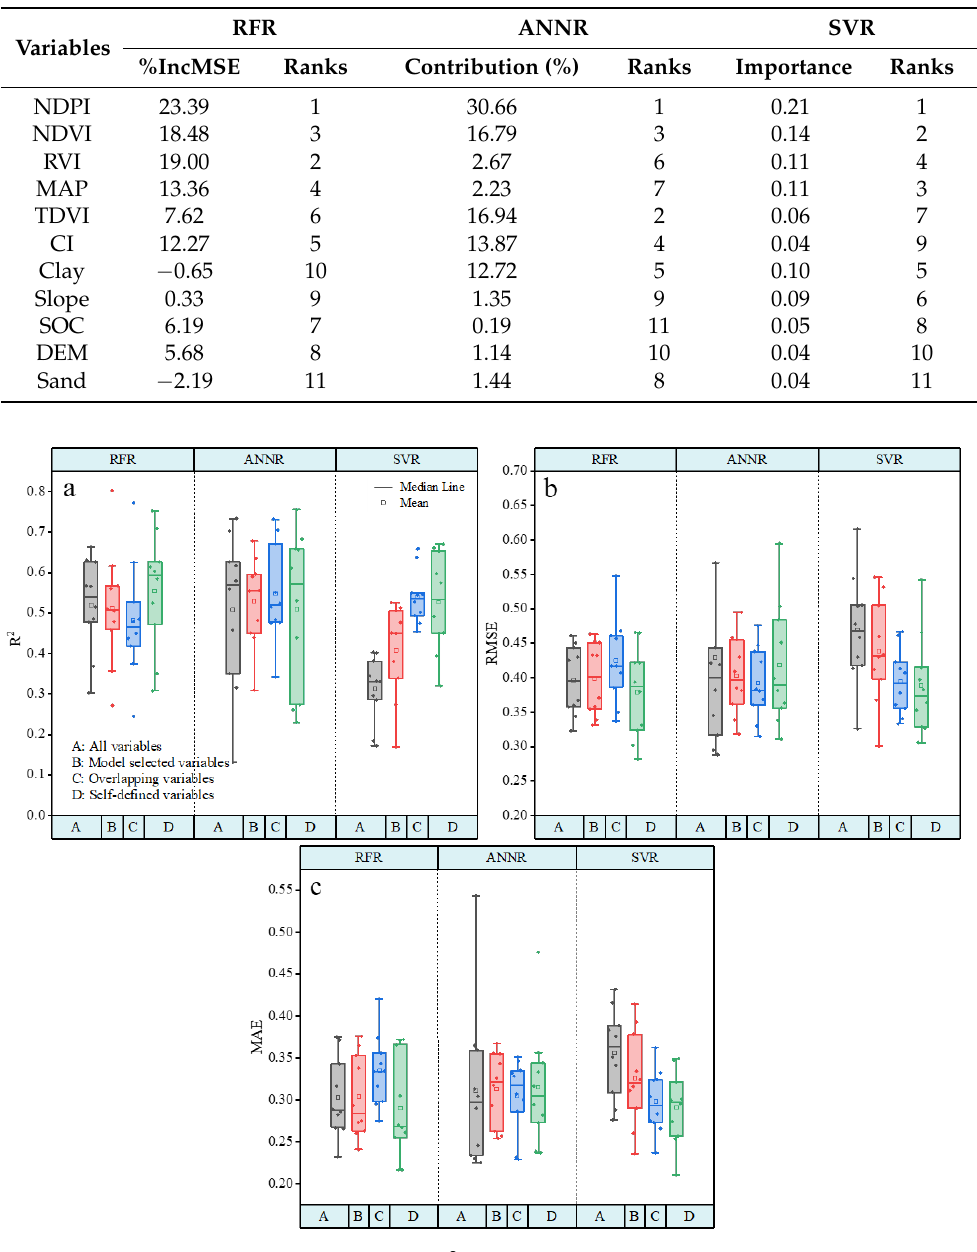
Figure 6. In situ measured vs. estimated LAI using the RFR-D model. Green points represent the meadow, yellow points represent the meadow steppe, blue points represent the typical steppe and purple points represent the desert steppe. The liner regression line is shown with the 95% confidence interval (dark shaded). 0.0